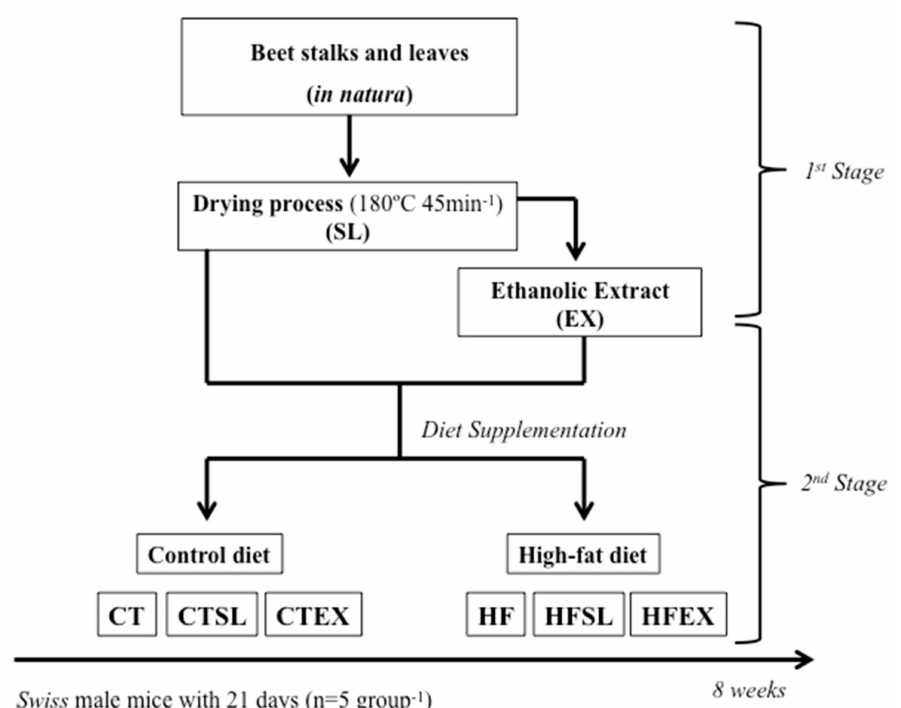
Figure 1. Experimental protocol. Stalks and leaves (SL); ethanolic extract (EX); the control (CT); standard diet with dried stalks and leaf (0.5% of dried stalks and leaves) (CTSL); : standard diet with stalk and leaf extract (190 mL of extract) (CTEX); high-fat diet (60% lipids) (HF); high-fat diet with dried stalks and leaf (60% lipids and 0.5% dehydrated beet stalks and leaves) (HFSL); high-fat diet with stalk and leaf extract (60% lipids and 19 mL of ethanolic extract)